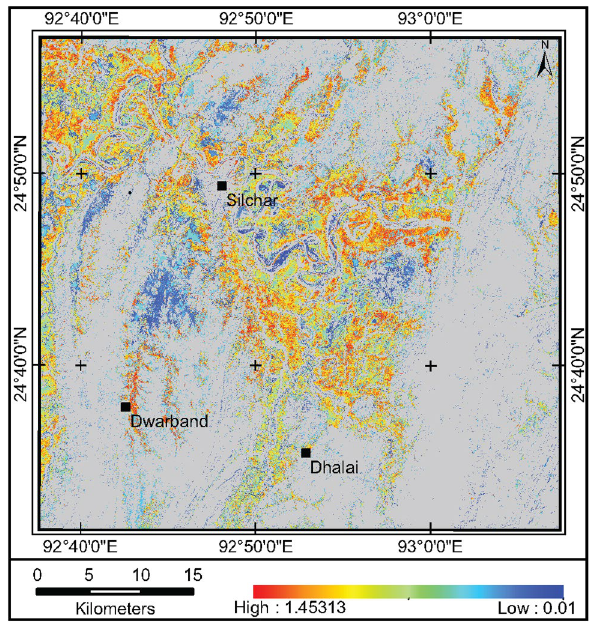
Fig. 8 Band ratio image (2 + 5)/(3 + 4) representing ferrous iron (Fe 2+ ) mineral-bearing areas as higher pixel values (lighter gray regions are areas of thick vegetation/water bodies)